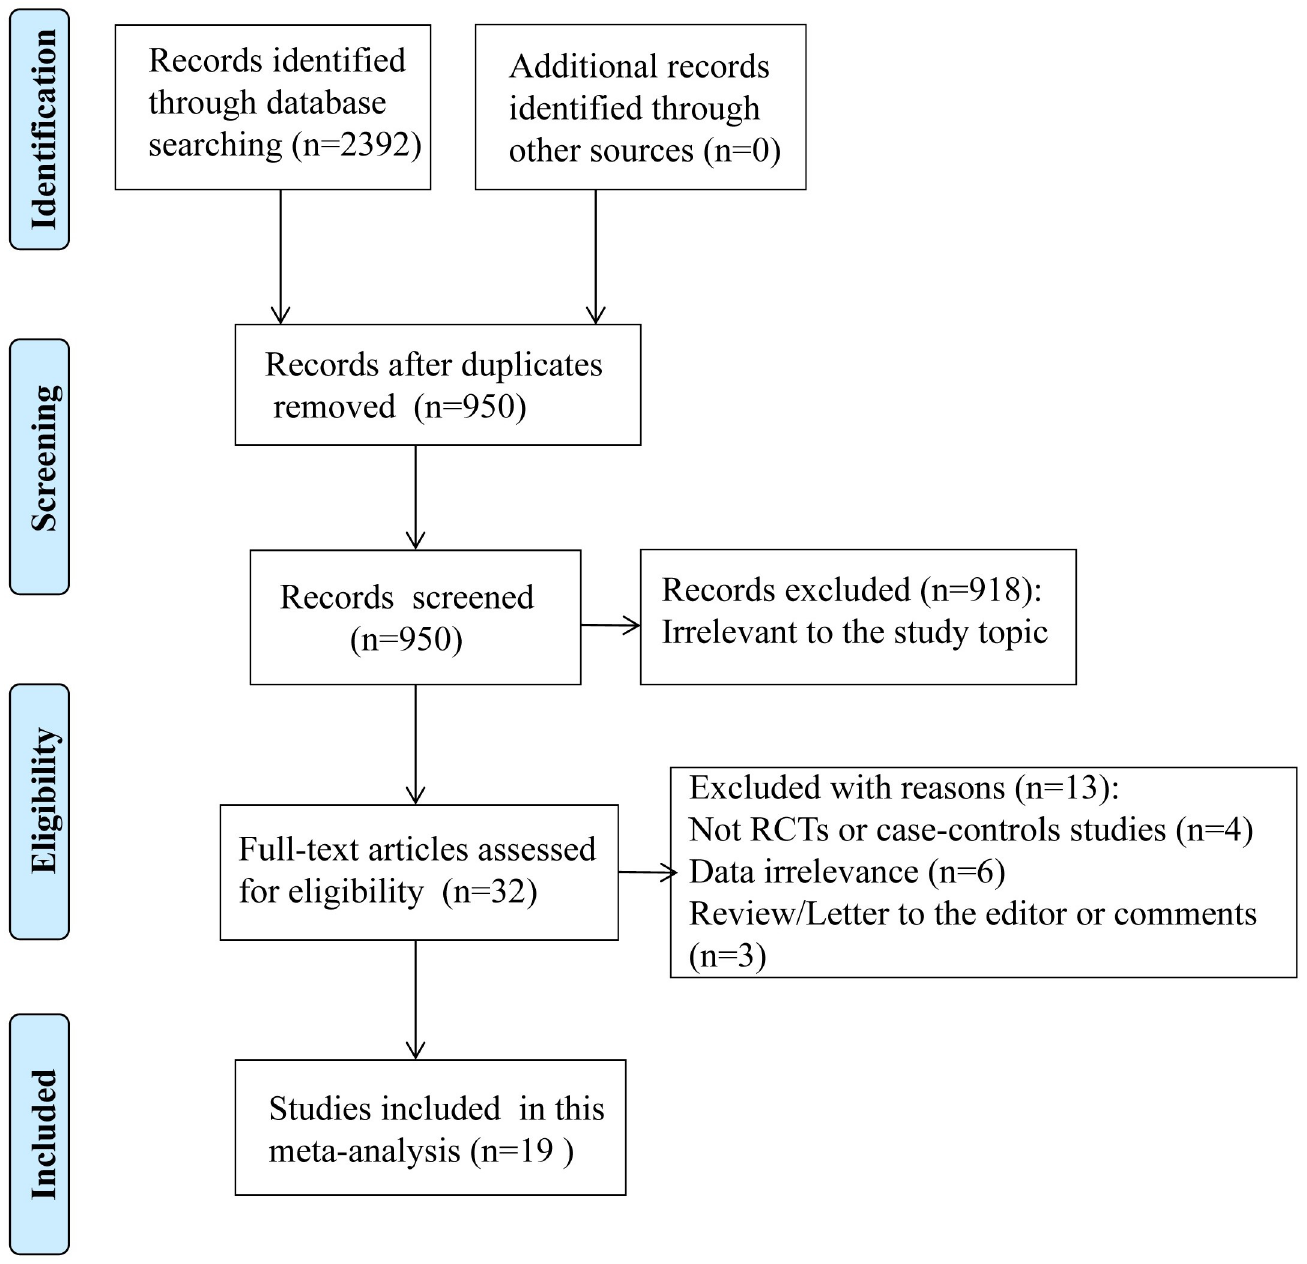
Fig 1. Flow diagram of studies included in the meta-analysis. PRISMA flow diagram showing the number of articles identified and evaluated during the review.